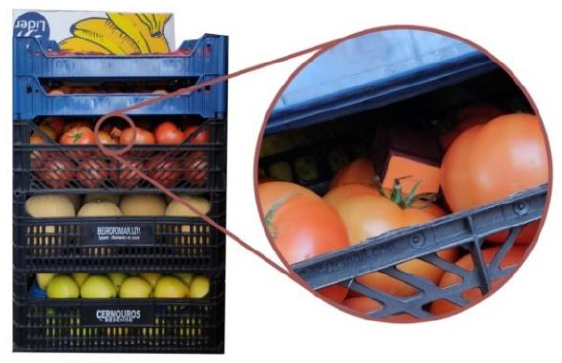
Figure 6. Placement of sensor 3.